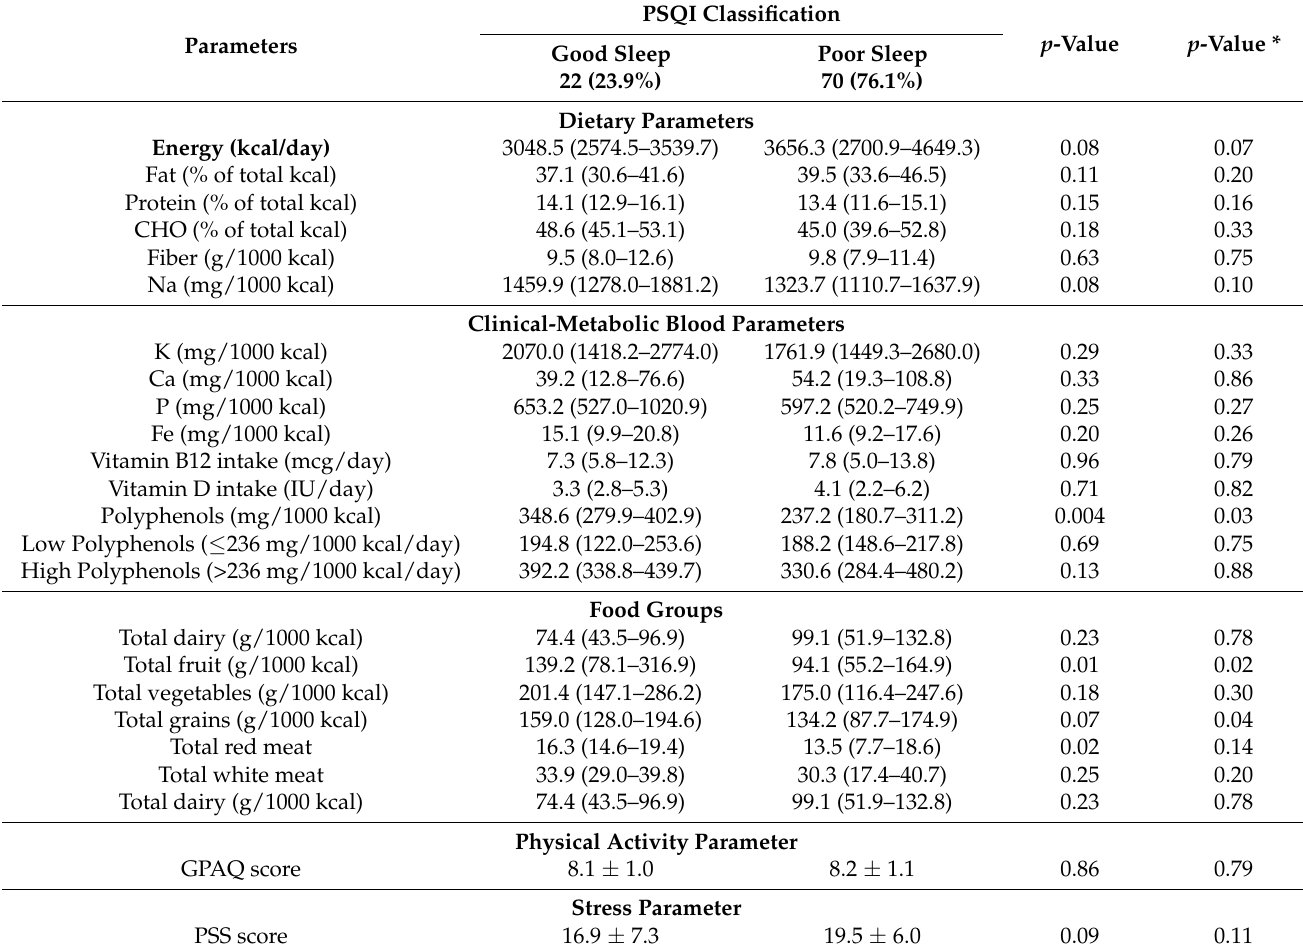
Table 2. Dietary intake, physical activity, and stress according to PSQI sleep